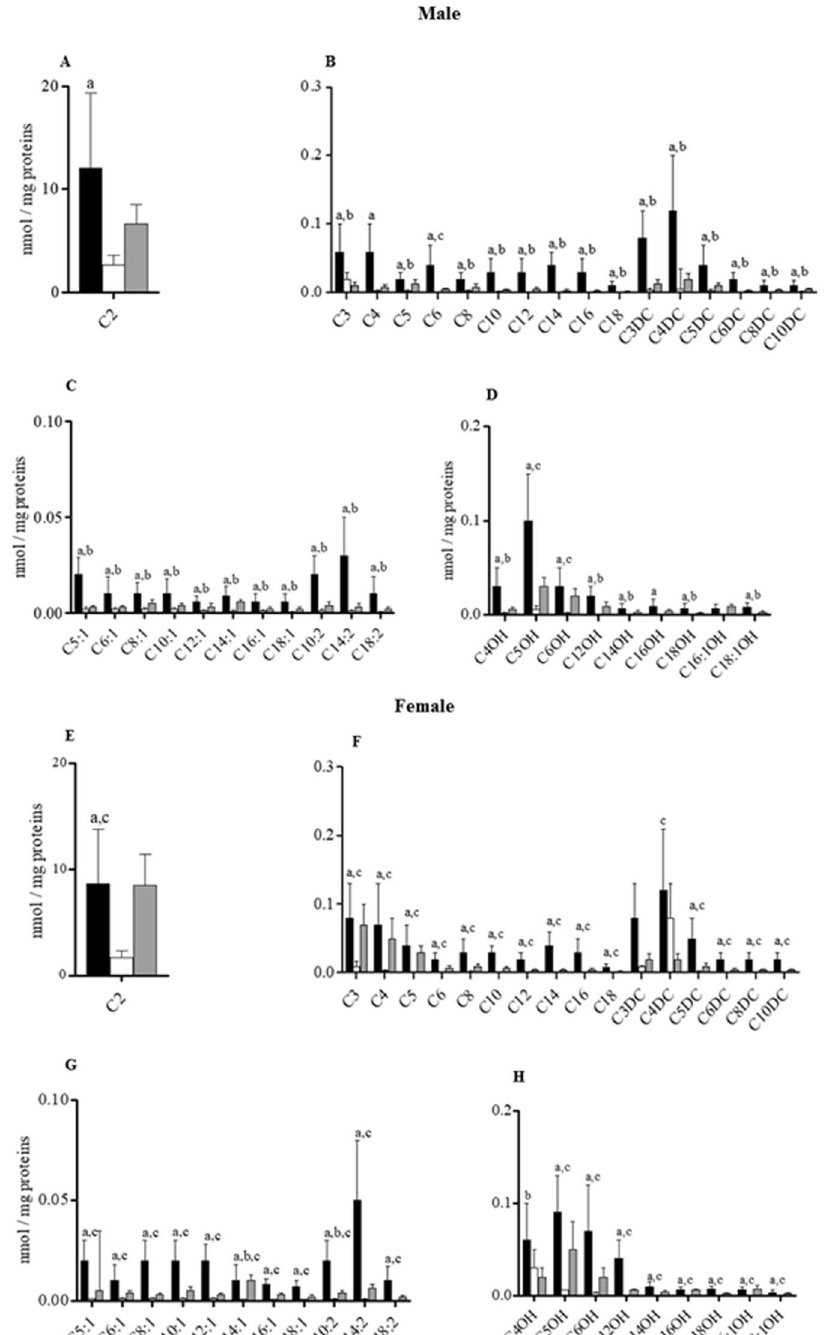
Figure 4. Intra-sex and inter-organ analysis of ACs in livers (black bars), hearts (white bars) and kidneys (grey bars) of male (M) and female (F) rats. Data are the medians ± MAD of 15 samples for each tissue and sex. a P < 0.05 between liver and heart; b P < 0.05 between liver and kidney; c P < 0.05 between heart and